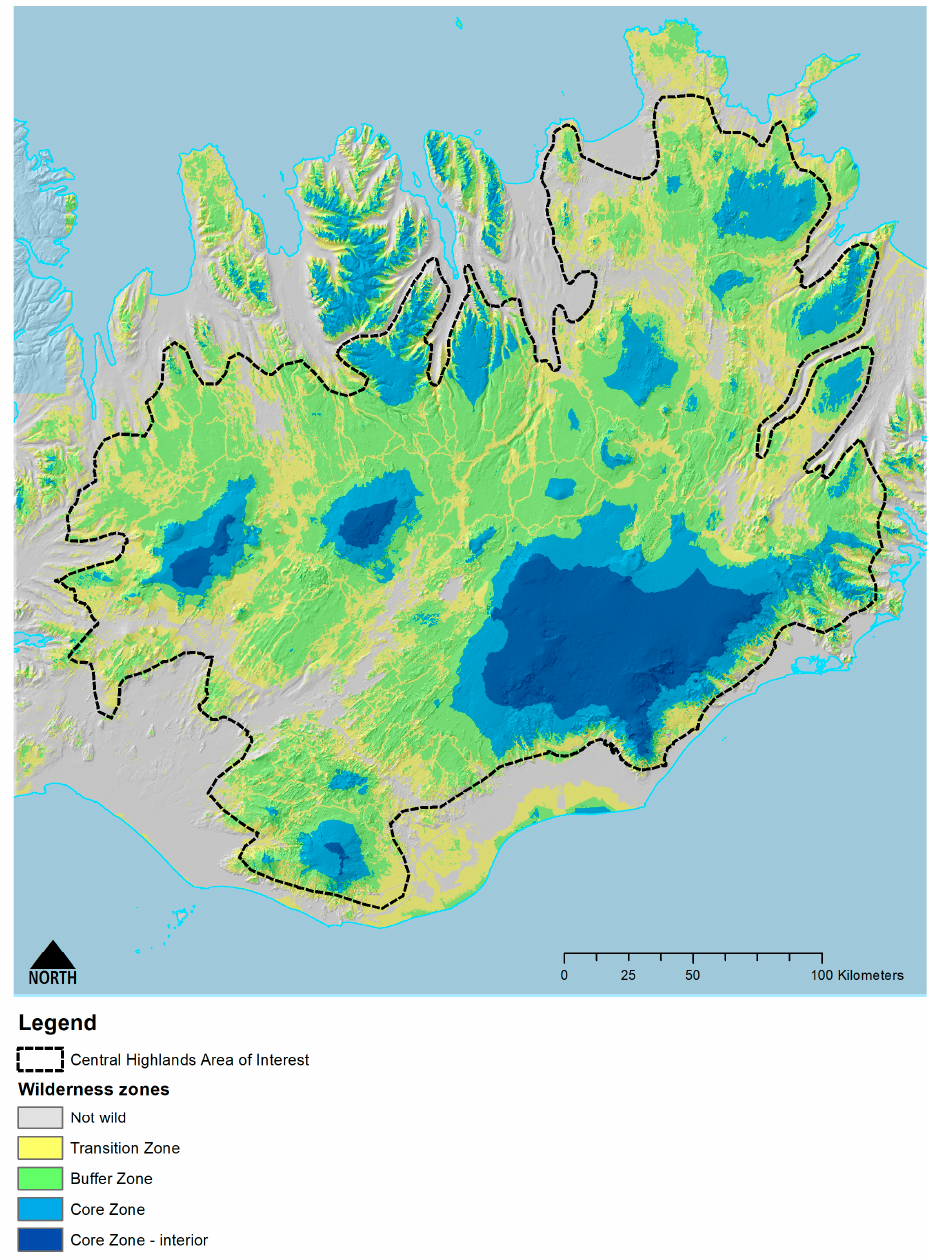
Figure 7. Wilderness zones in the Central Highlands .